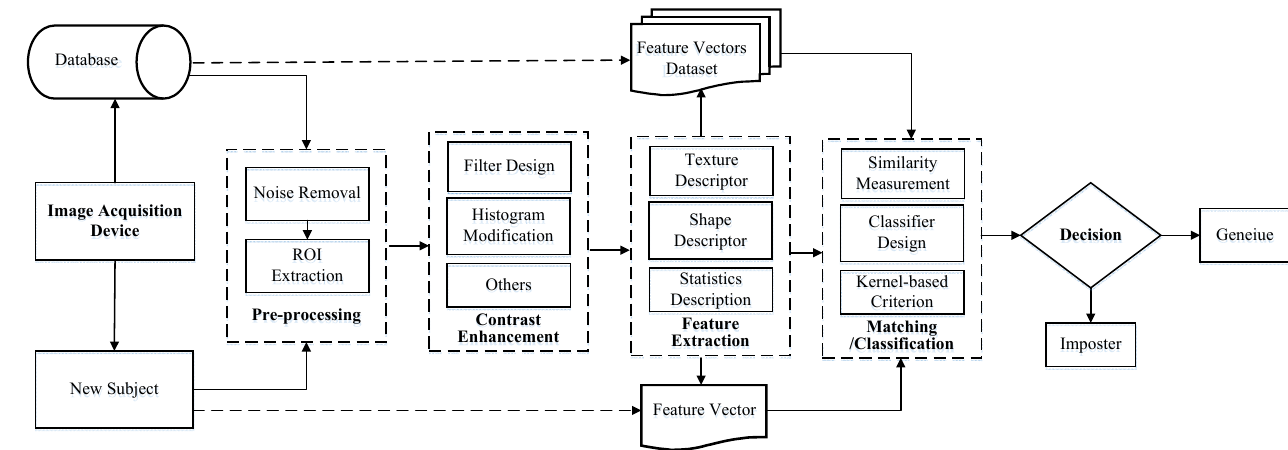
Figure 1. General framework of hand vein recognition